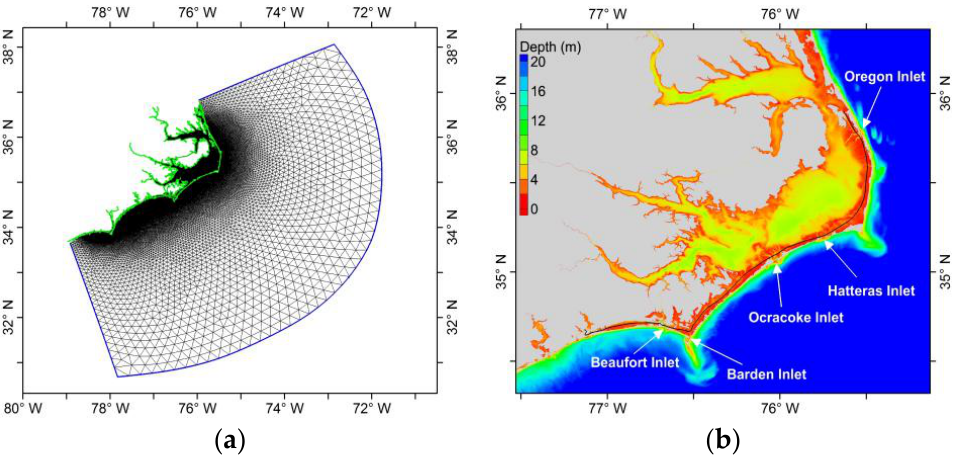
Figure 2. ( a ) The triangular model grid (the blue lines delineate the open ocean boundary; the green lines delineate the land boundary); ( b ) Model grid bathymetry in North Carolina coastal waters (the regions deeper than 20 m use the same blue color; the black line shows the location for longitudinal profiles in Figures 15 and 16). Table 1. Bathymetric data and morphological parameters around five North Carolina inlets.